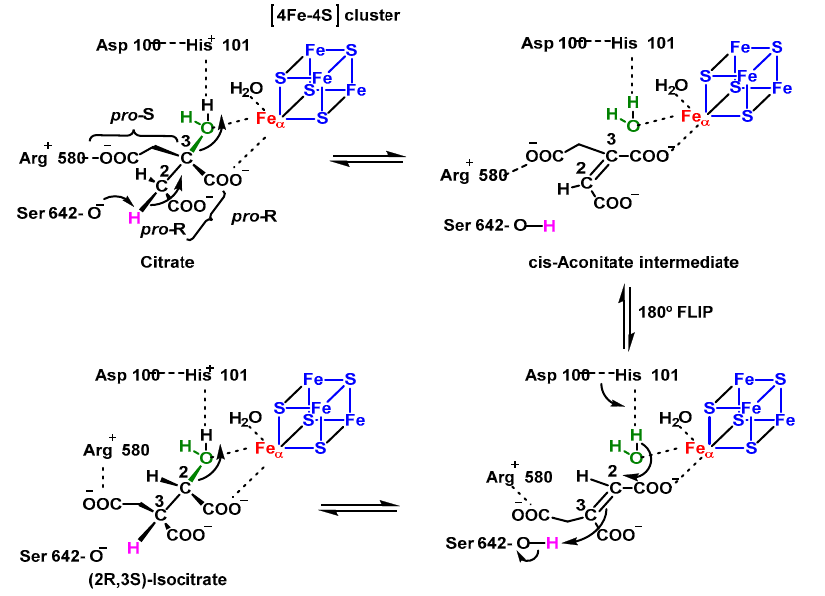
Figure 44. Mechanism of isomerisation of citrate to isocitrate by the enzyme aconitase. The aconitase differentiates between the two carboxylic groups of the citrate uniting it by three points.